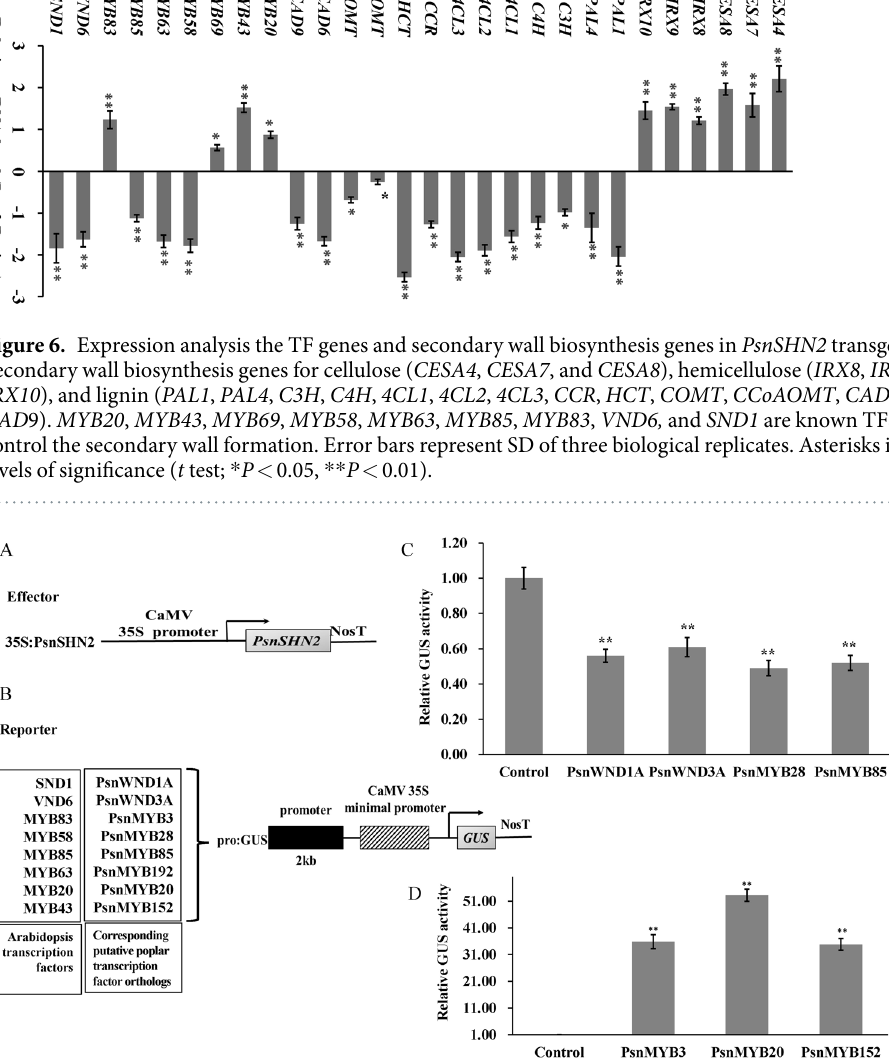
Figure 7. Activation or repression of the promoters of poplar TFs by PsnSHN2. ( A,B ) Diagrams of the effector and reporter constructs. ( C,D ) The expression of the GUS was repressed and activated by PsnSHN2 , respectively. GUS activity in tobacco leaves transfected with the reporter construct alone was used as a control and was set to 1. Error bars represent SD of three biological replicates. Asterisks indicate levels of significance of differential expression ( t test; * P <